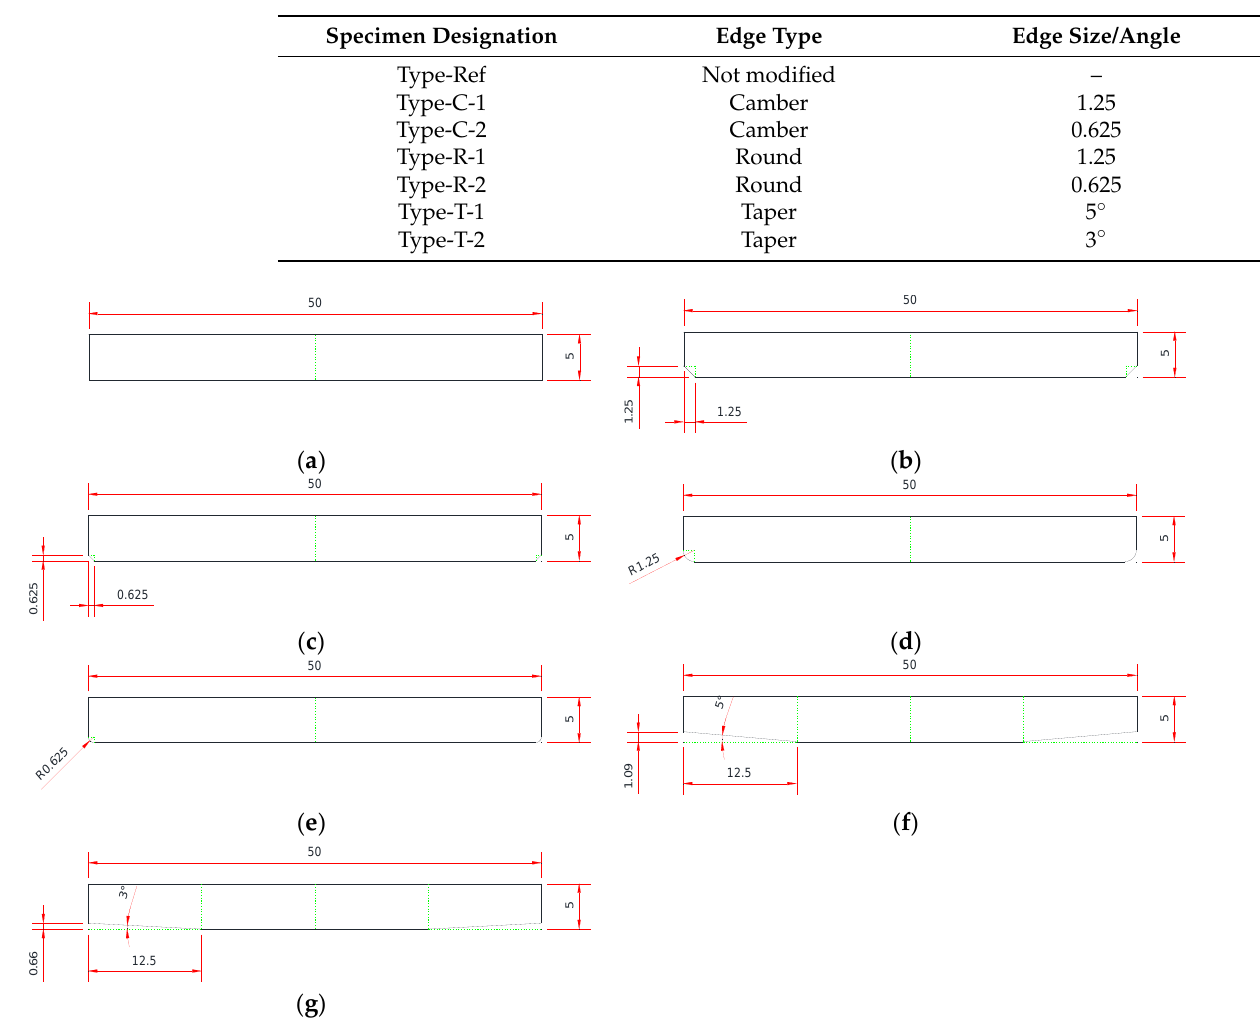
Figure 6. Shape and dimensions of specimens: ( a ) Type-Ref; ( b ) Type-C-1; ( c ) Type-C-2; ( d ) Type-R-1; ( e ) Type-R-2; ( f ) Type-T-1; ( g ) Type-T-2.